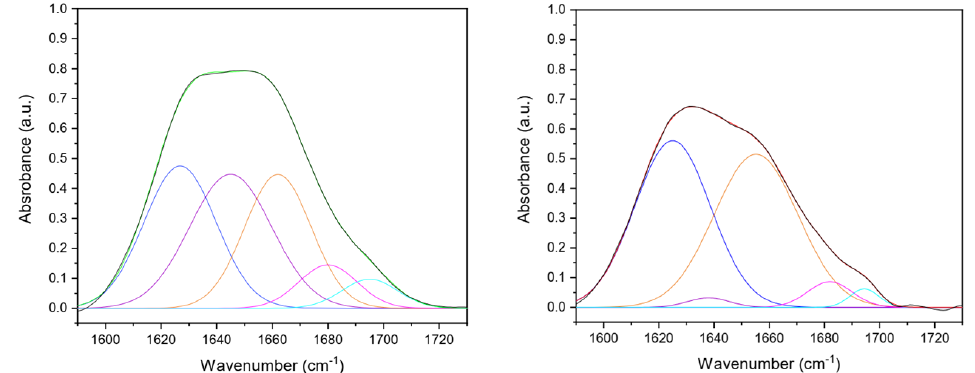
Figure 1. ( A ) FT-IR spectra of uncrosslinked (down) and cross-linked (up) collagen membranes. ( B ) Chemical structure of collagen after cross-linking.